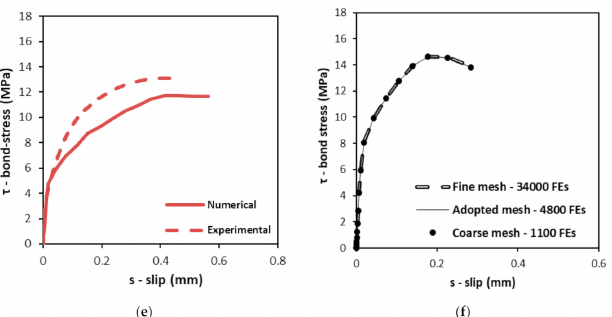
Figure 5. Numerical vs. experimental bond-slip curves of ( a ) RC, ( b ) C100C-Val, ( c ) C100C-Ret, ( d ) C100F-Vim, ( e ) C100F-Amb and ( f ) influence of mesh discretization on the bond-slip behavior of